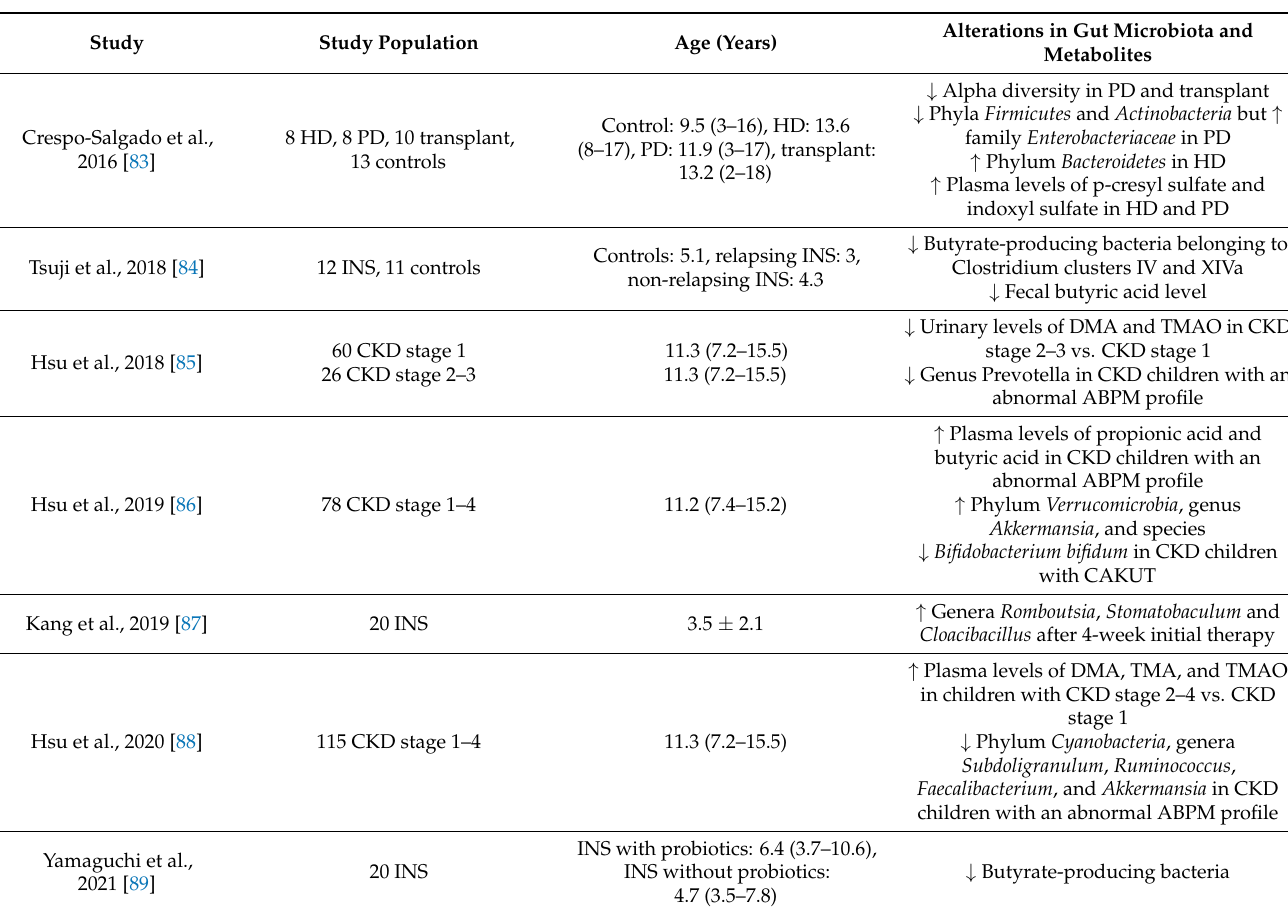
Table 1. Summary of studies investigated links between gut microbiota and pediatric chronic kidney